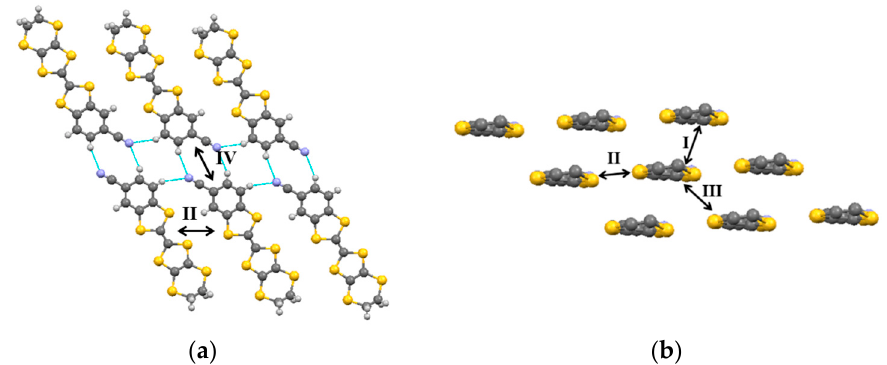
Figure 3. Details of donors packing in β ”-(CNB-EDT-TTF) 4 BF 4 : ( a ) partial view perpendicular to the donors with blue lines emphasizing C–N···H–C interactions, as a combination of R 22 (10) and R 22 (8) synthons in a two-dimensional network of coplanar donors; ( b ) View of one donor layer along the molecular long axis showing a β ”-type packing pattern, with identification of the distinct intralayer interactions I, II and III. Table 1. Absolute values of the | β HOMO-HOMO | interaction energies (meV) for the different donor ··· donor interactions in the β ”-(CN-BEDT-TTF) 4 X salts (I, along the stacks, II, lateral π